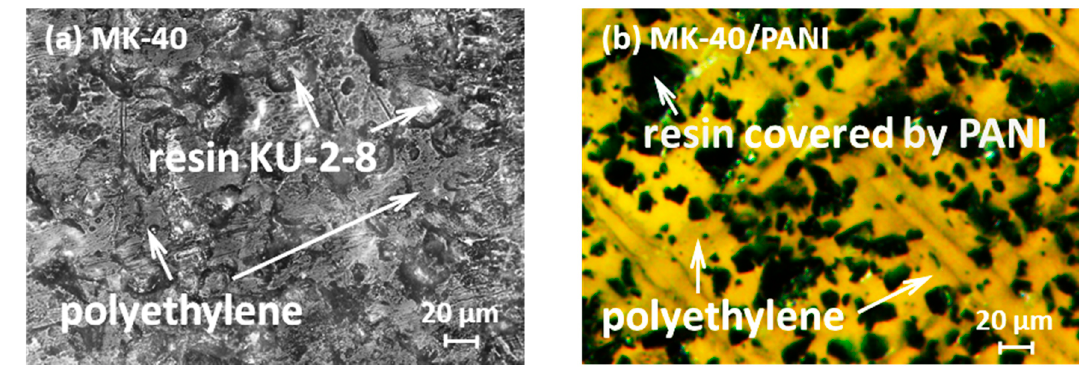
Figure 1. Image of the surface of swollen ( a ) MK-40 and ( b ) MK-40 / PANI membranes obtained with a Zeiss AxioCam MRc5 light microscope.